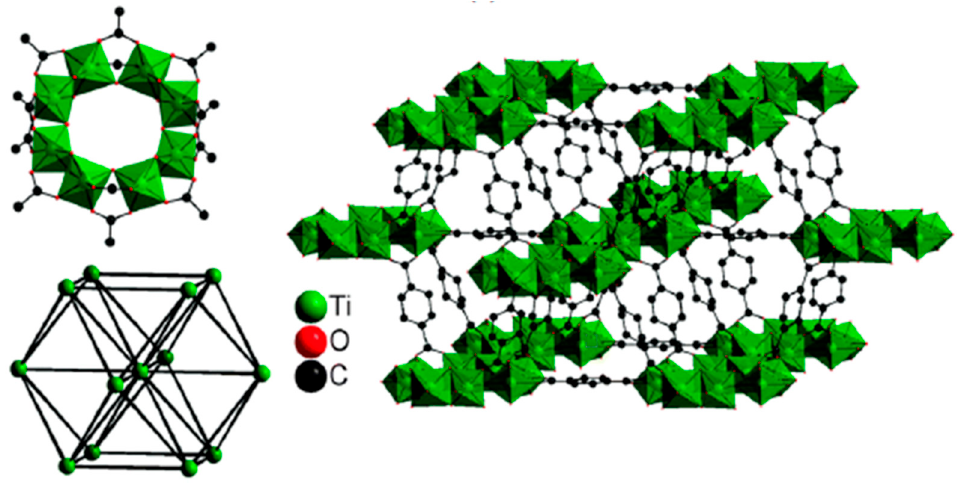
Figure 8. Materials of Institute Lavoisier (MIL)-125 structure [107].